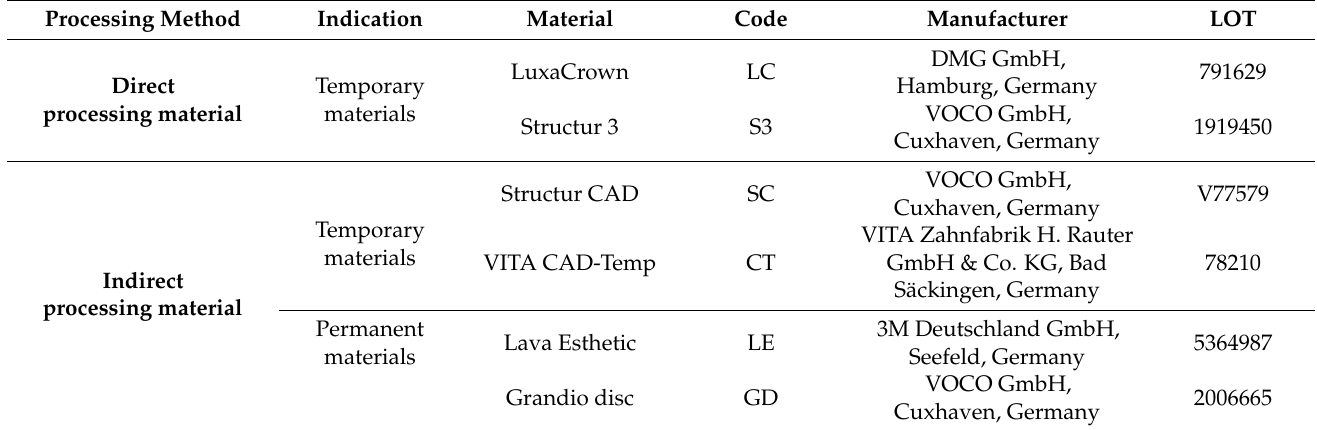
Table 2. Investigated materials: processing method, indication, product name, code and